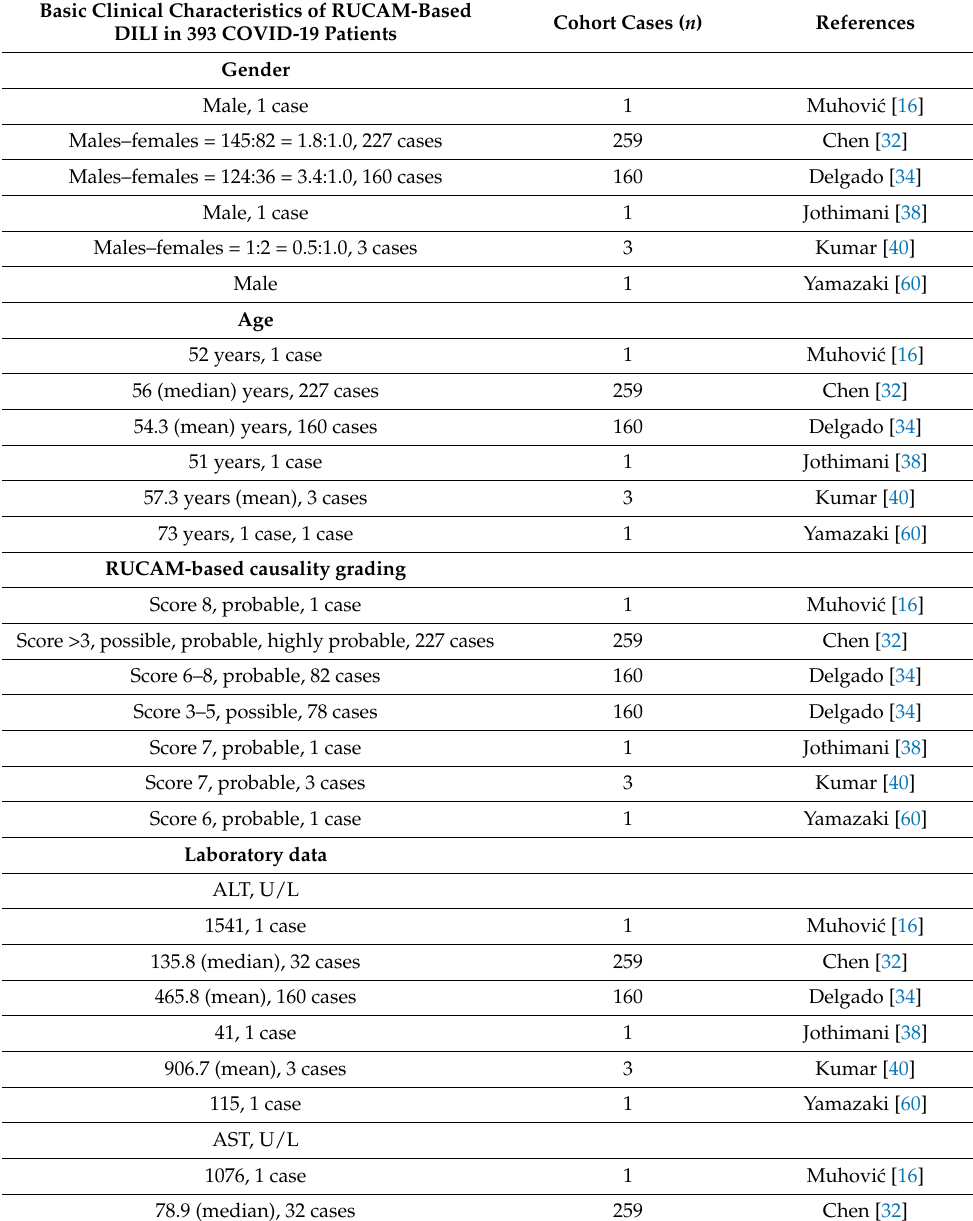
Table 3. Clinical characteristics of RUCAM-based DILI in 393 COVID-19 patients. Basic Clinical Characteristics of RUCAM-Based DILI in 393 COVID-19